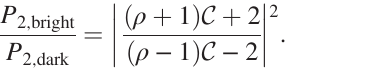
FIG. 1. Bright and dark hybridized magnon-phonon states or “ magnon polarons ” in a YIG j GGG j YIG. Left: out-of-phase negative (top row) and in-phase positive (bottom row) mutual coupling between two macrospins m 1 and m 2 in the outer YIG films when hybridized with an (a) odd or (b) even index i standing phonon mode u i . δ ¼ ð ω 2 − ω 1 Þ = 2 is the half of the splitting of the resonance frequencies of m m j Ψ i ¼ ð m ; u ; m Þ of the tripartite system as a function of the detuning δ , keeping ð ω 1 and 2 . Center: amplitudes 1 i 2 constant. The density plots (c) – (f) show in bivariate colors [luminance:amplitude and hue:phase; cf. color wheel in (e)] the absorbed ffiffiffi p 2 power in response to an excitation j ˆ ε i ¼ ð 1 ; 0 ; 1 Þ = by [(c) and (e)] the acoustic subsystem P a ∝ Im h ˆ u j χ j ε i and [(d) and (f)] the magnetic top layer P 2 ∝ Im h ˆ m 2 j χ j ε i , with h ˆ u j ¼ ð 0 ; 1 ; 0 Þ and h ˆ m 2 j ¼ ð 0 ; 0 ; 1 Þ . Right: (g) and (h) are the corresponding spectra of P 2 at δ ¼ 0 . The white (black) circles indicate the bright (dark) states observed at the triple crossing; see Eq. (5). The hybridized bright and dark magnetic states are illustrated on the right side of (g) and (h),